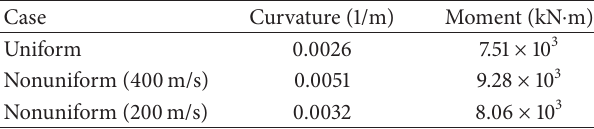
Table 4: Peak response of moment force and